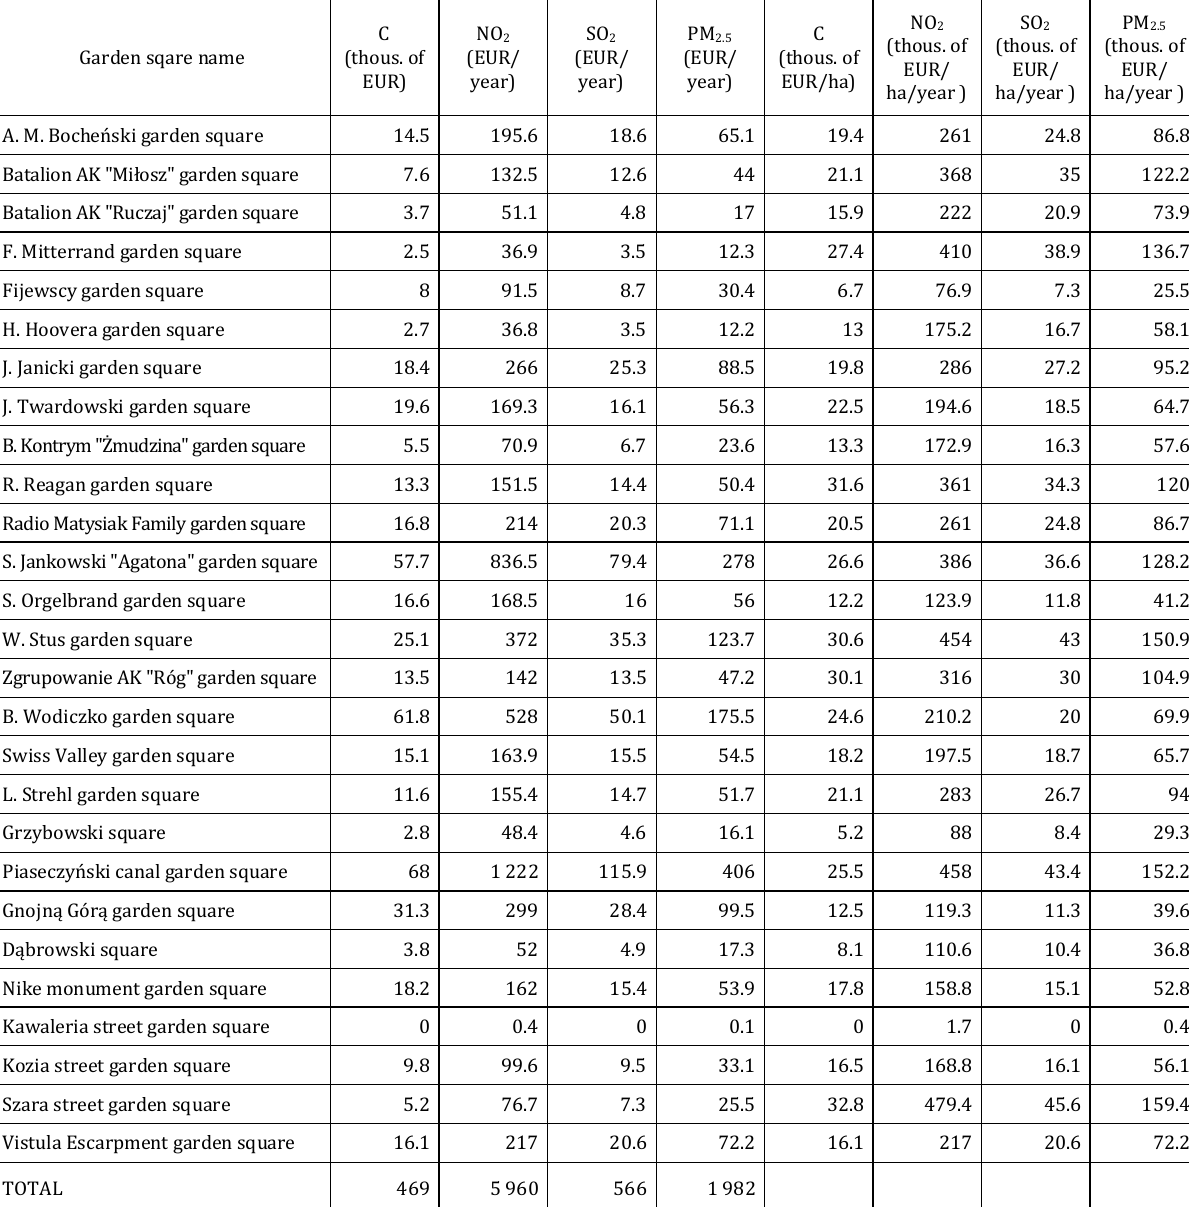
Table 5. Economic value of the studied ecosystem services across 27 garden squares in Warsaw Garden sqare name